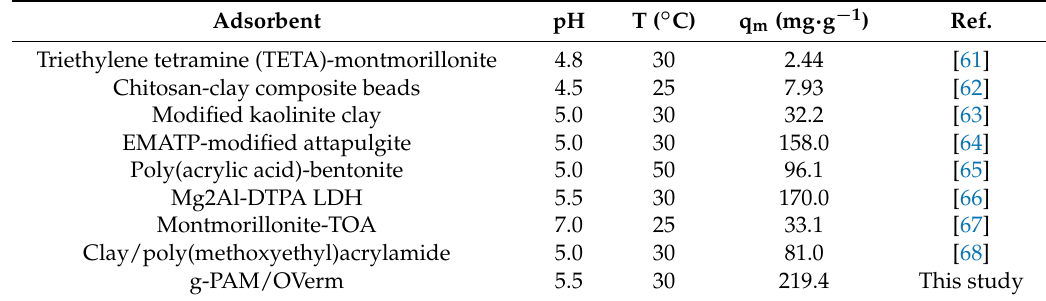
Table 5. Comparison of Pb(II) adsorption capacity on g-PAM/OVerm and other clay-based adsorbents.